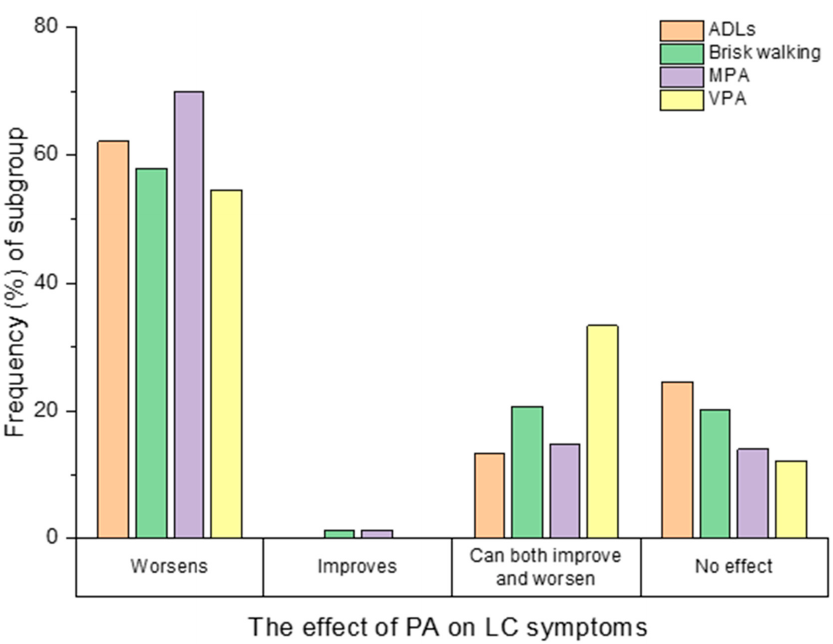
Figure 2. How completing activities of daily living (ADLs, n = 468), brisk walking ( n = 169), moderate physical activity (MPA, n = 223) and vigorous physical activity (VPA, n = 33) effected participants Long COVID (LC) symptoms.